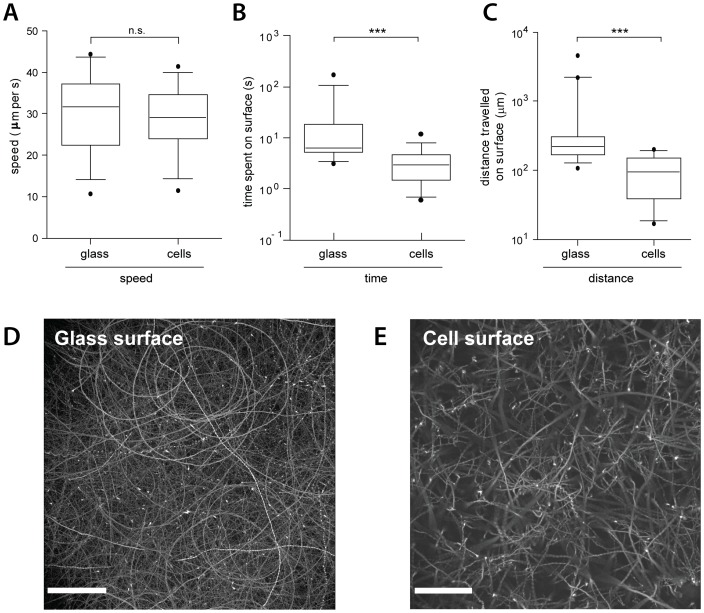
NSS of S. Typhimurium on cellular and artificial surfaces.Quantifications of time and distance of S.TmΔ4(pGFP) swimming along the bottom of a glass dish, with or without seeded cells. (A–C) Comparison of the speed, the time spent in NSS, or the distance travelled on a cellular and a glass surface, respectively. The figure summarizes 17–22 bacteria per condition from 2 independent experiments. ***: p<0.0001. (D), (E) overlay of all frames (maximum intensity plot; Volocity software) from a 5-minute movie (10 frames/sec; Leica DMI-6000B, 20× air objective 0.7 NA, 2 fold optovar) in the GFP channel of S.TmΔ4(pGFP) movement on a glass-or a cellular surface, respectively. Note the shorter and more linear tracks on the cellular surface. Scale bar: 57 µm.